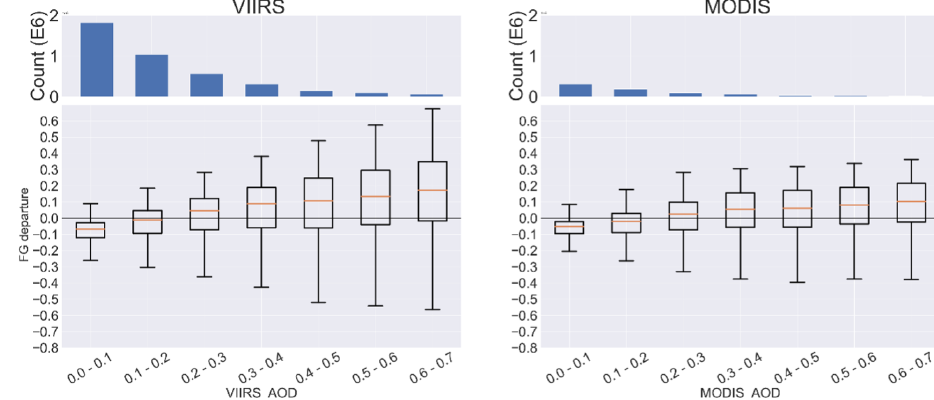
Figure 15. Global statistics of the first-guess (FG) departure for a distinct range of AOD (DJF period) over